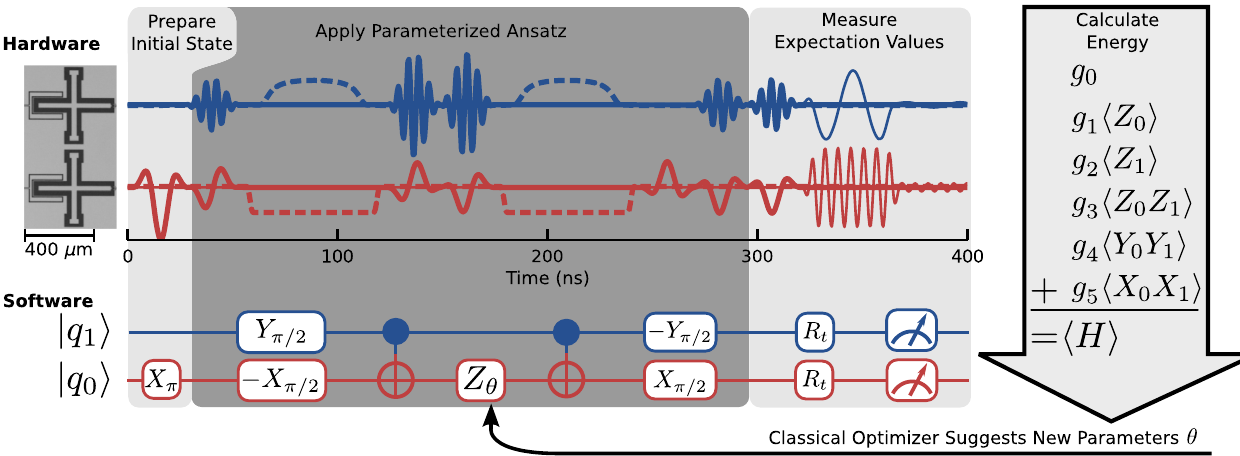
FIG. 1. Hardware and software schematic of the variational quantum eigensolver. (Hardware) micrograph shows two Xmon transmon qubits and microwave pulse sequences to perform single-qubit rotations (thick lines), dc pulses for two-qubit entangling gates (dashed lines), and microwave spectroscopy tones for qubit measurements (thin lines). (Software) quantum circuit diagram shows preparation of the Hartree-Fock state, followed by application of the unitary coupled cluster ansatz in Eq. (3) and efficient partial tomography ( R measure the expectation values in Eq. (1). Finally, the total energy is computed according to Eq. (4) and provided to a classical optimizer which suggests new